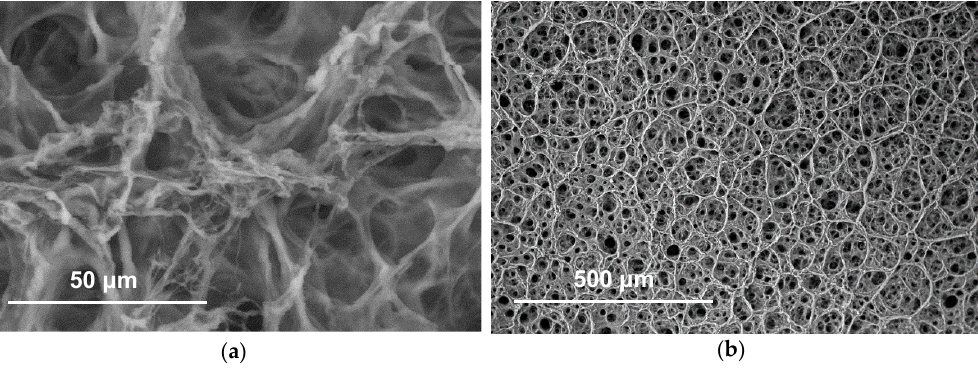
Figure 6. Cool-stage SEM images of sample CollPEG4. Magnifications: ( a ): 1000×; ( b ): 100×.